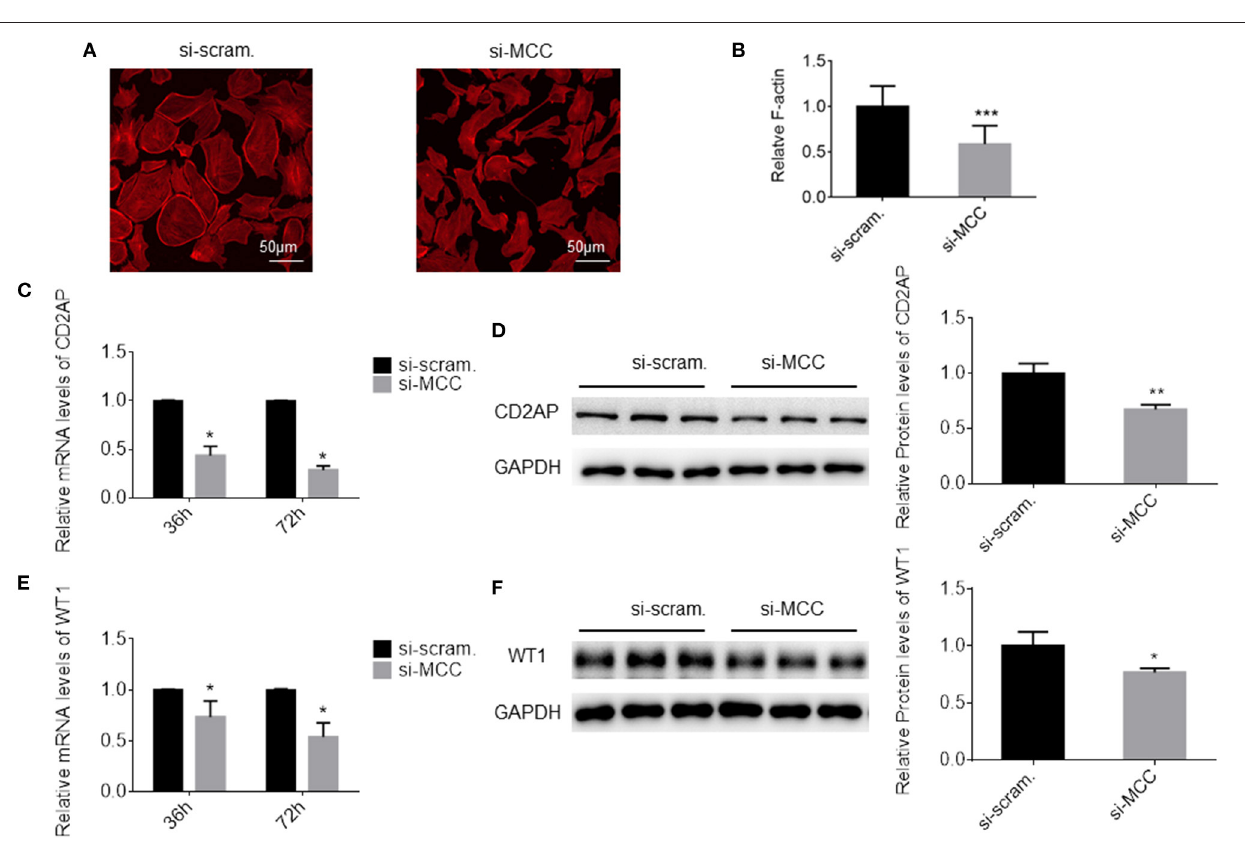
FIGURE 5 | MCC silencing resulted in injury in podocytes. (A) Phalloidin staining of the cells treated with scramble control and si-MCC for 72h. (B) Quantification of the staining intensity using ImageJ showed a significant reduction of actin stress fibers in the cells treated with si-MCC compared with scramble control. (C) qPCR quantification of CD2AP mRNA in control cells and the cells treated with si-MCC at 36h and 72 post transfection, respectively. (D) Immunoblotting of the CD2AP protein in the cell samples in C to confirm CD2AP downregulation at the protein level. Quantification of the blot is shown on the right. (E) qPCR analysis of WT1 in the cells treated with scramble control and si-MCC, respectively. (F) Immunoblotting of WT1 in the samples in (E) and the quantification shown on the right. The data represent the mean ± SD of three independent experiments. * p < 0.05, statistically significant; ** p < 0.01 and *** p < 0.001, statistically very